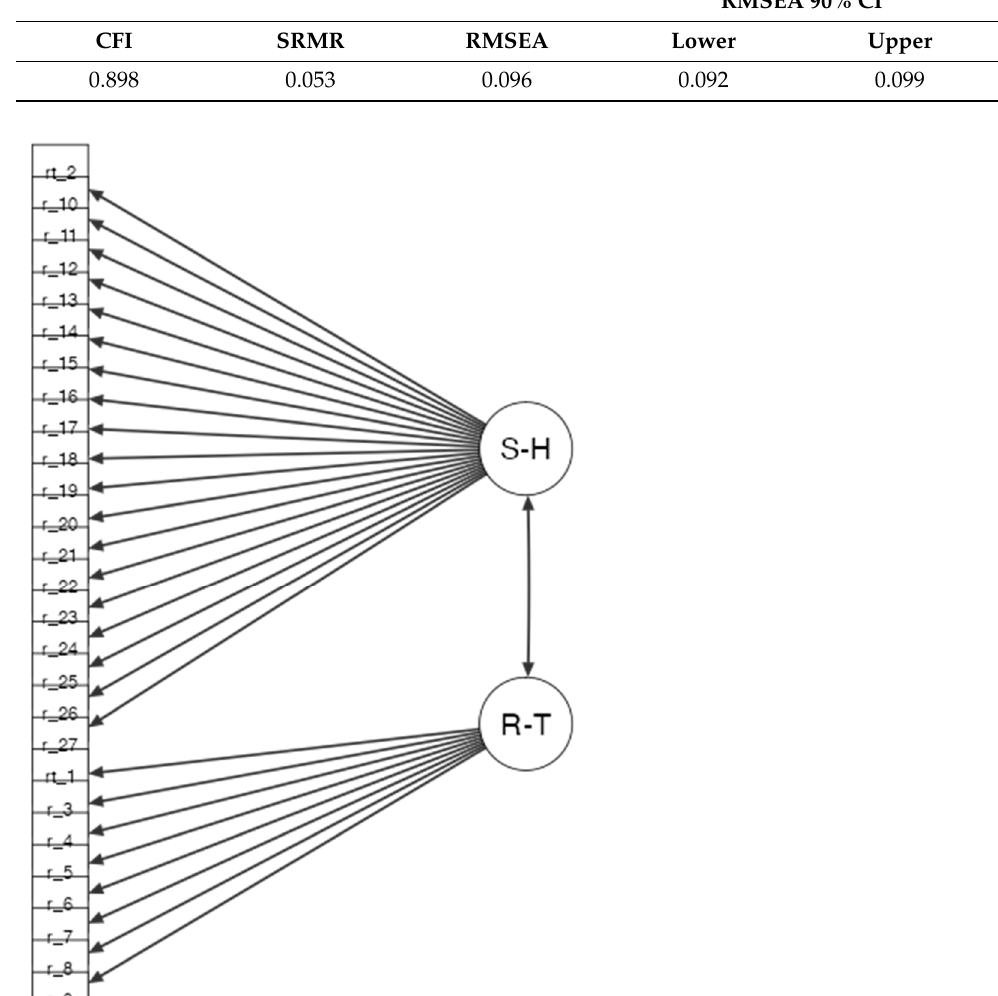
Table 4. Fit Measures with Modi fi cation Indices.